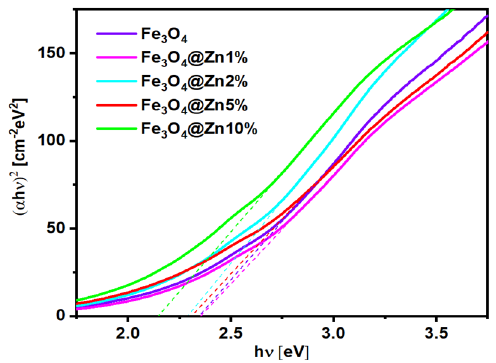
Figure 5. Tauc plot for the SPIONs with different content of zinc dopant.